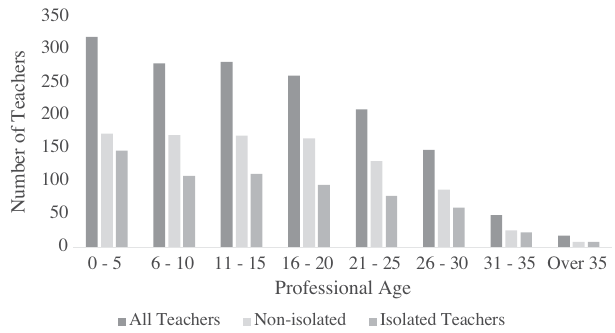
FIG. 4. Distribution of physics teachers by professional age.